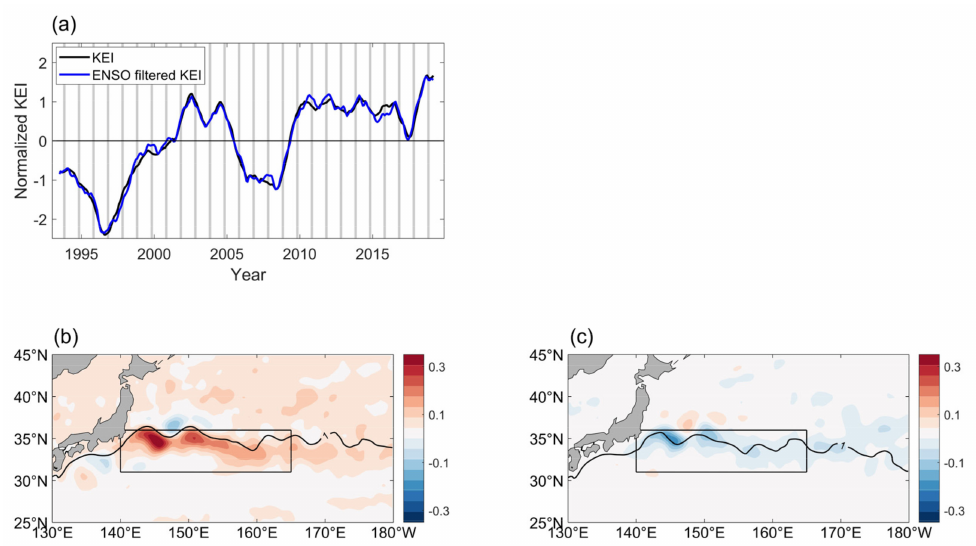
Figure 1. ( a ) Time series of the monthly normalized KEI (black line) and ENSO-filtered KEI (blue line) based on the AVISO SSHA observations. The KEI in OND is marked by grey bars. Composite SSHA (shading, unit: m) and KE axis defined by the 1 m sea surface height (black curve, unit: m) for the ( b ) SPs and ( c ) USPs from 1993 to 2018. The black rectangles in ( b , c ) denote the area used for calculating the